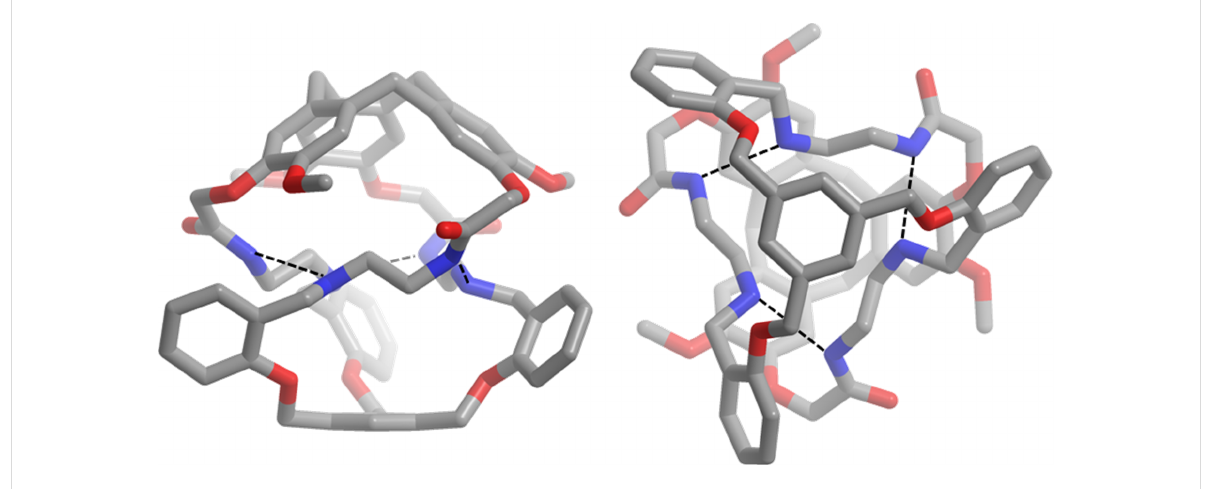
Figure 2: X-ray molecular structure of 1 . Hydrogen atoms are omitted for clarity; dashed lines represent hydrogen bonds.